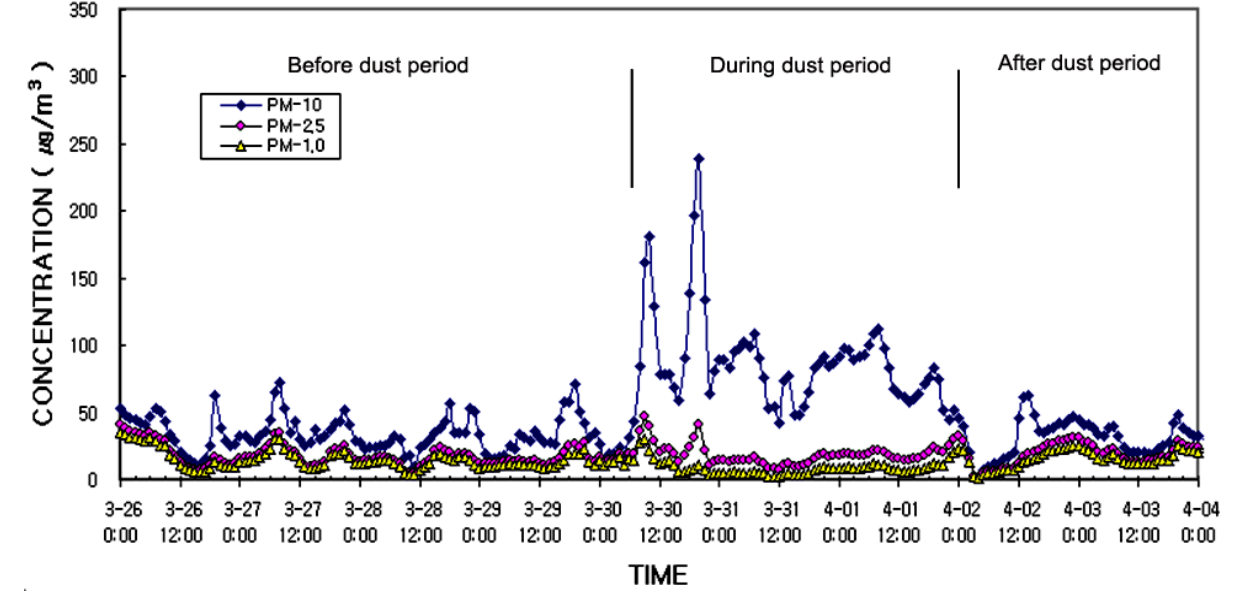
Figure 2 . Hourly concentration ( μg /m 3 ) of PM 10 , PM 2.5 , and PM 1 at an aerosol sampling point of Figure 2. Hourly concentration ( µ g/m 3 ) of PM 10 , PM 2.5 , and PM 1 at an aerosol sampling point of Gangwon Meteorological Administration (37 ° 4 5′ N, 128°5 4′ E; 20 m height over the Mean Sea Level) Gangwon Meteorological Administration (37 ◦ 45 (cid:48) N, 128 ◦ 54 (cid:48) E; 20 m height over the Mean Sea Level) in Gangneung city, from March 26 to 4 April 2004. in Gangneung city, from March 26 to 4 April 2004.